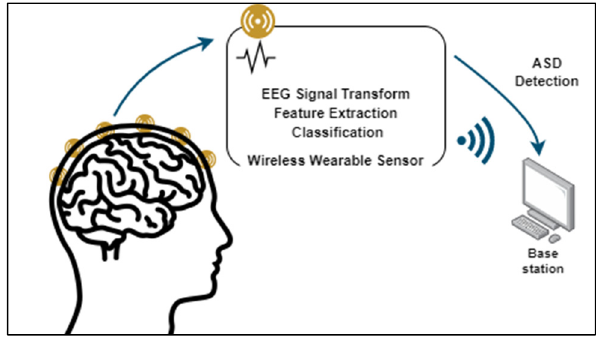
Figure 2. On-node EEG-based ASD detection